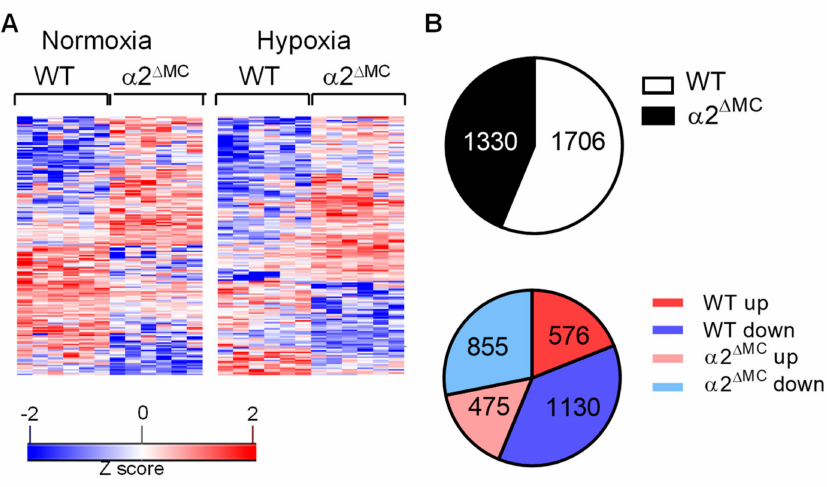
Figure 1. Di ff erentially expressed proteins in monocytes from wild-type and AMP-activated protein kinase (AMPK) α 2 ∆ MC littermates. Bone marrow monocytes were isolated and maintained under normoxic or hypoxic conditions for 16 h. ( A ) Heat map showing di ff erential protein expression in monocytes from wild-type (WT) and AMPK α 2 ∆ MC ( α 2 ∆ MC ) mice. Adherent cells were cultured for 16 h in normoxic (left) or hypoxic conditions (right) and total proteins were subjected to digestion with trypsin and proteomics; n = 6 mice per group. ( B ) Proteins di ff erentially regulated by hypoxia in monocytes from wild-type (WT) and AMPK α 2 ∆ MC ( α 2 ∆ MC ) mice; upper panel: total numbers of di ff erentially regulated proteins, (lower panel) up- and down-regulated